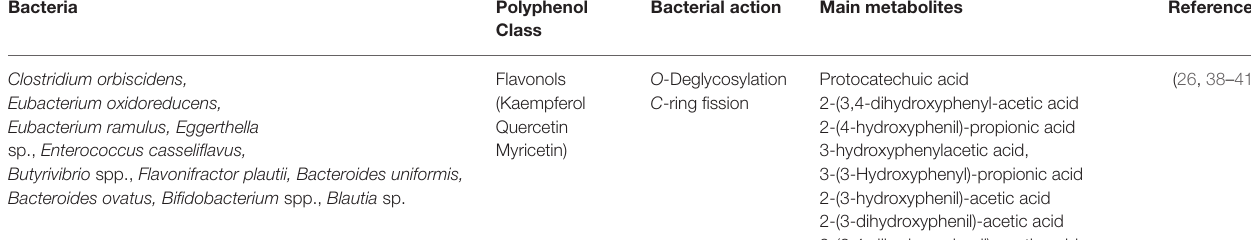
TABLE 2 | Polyphenols metabolism by gut microbiota in